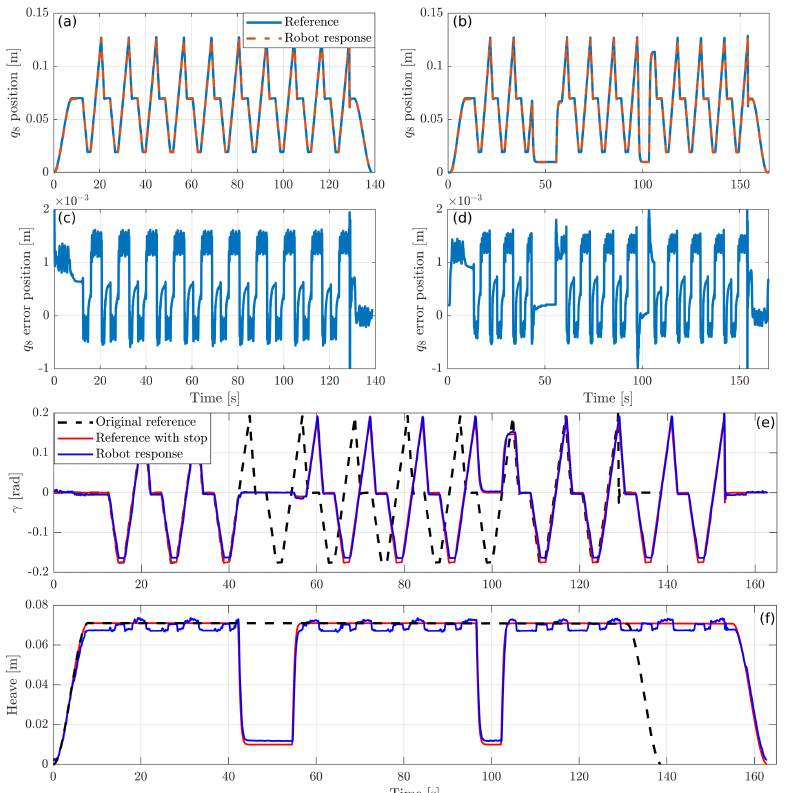
Figure 16. The response of the generalized coordinate q 8 of the real robot is shown in ( a ) while the effect of soft-stopping is shown in ( b ). ( c , d ) show the tracking error in both cases. ( e , f ) demonstrate the effect of soft-stopping on pitch and heave